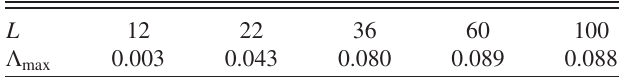
TABLE I. The largest Lyapunov exponent for different spatial domain